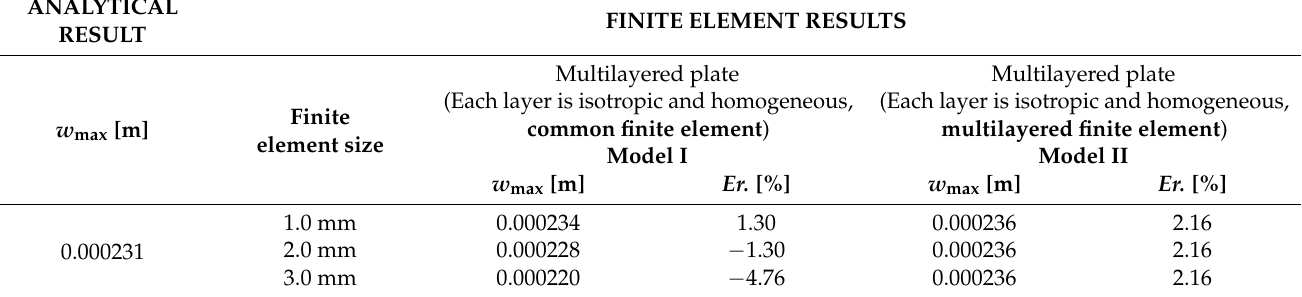
Table 7. The values of the maximum transverse